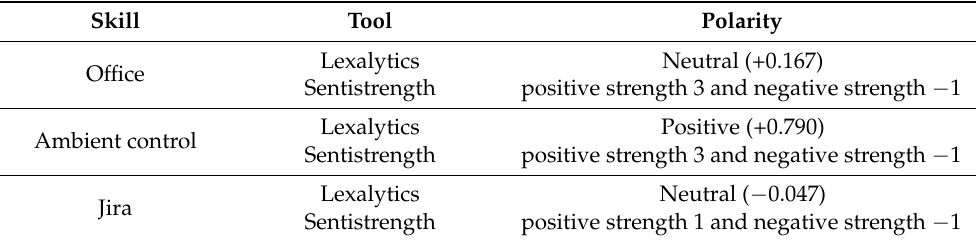
Table 5. Polarity results for the last question of the survey, using different tools.